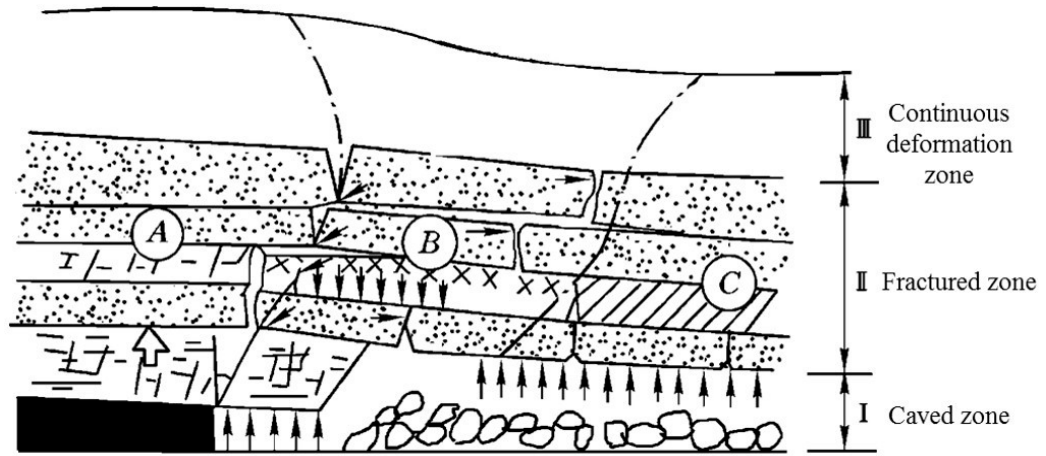
Figure 1. Zones of disturbance in response to longwall mining (Peng 2008).